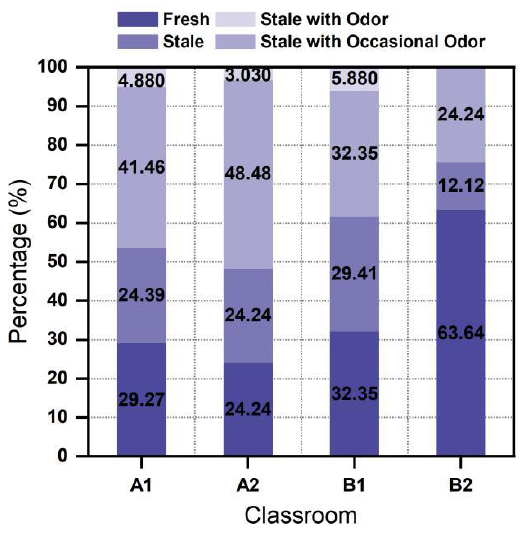
Figure 13. The percentage of the votes for the air freshness categories in different classrooms.